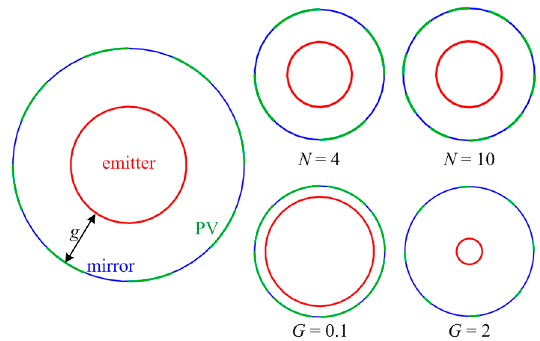
Figure 4. Schematics and the changed variables of configuration 1.